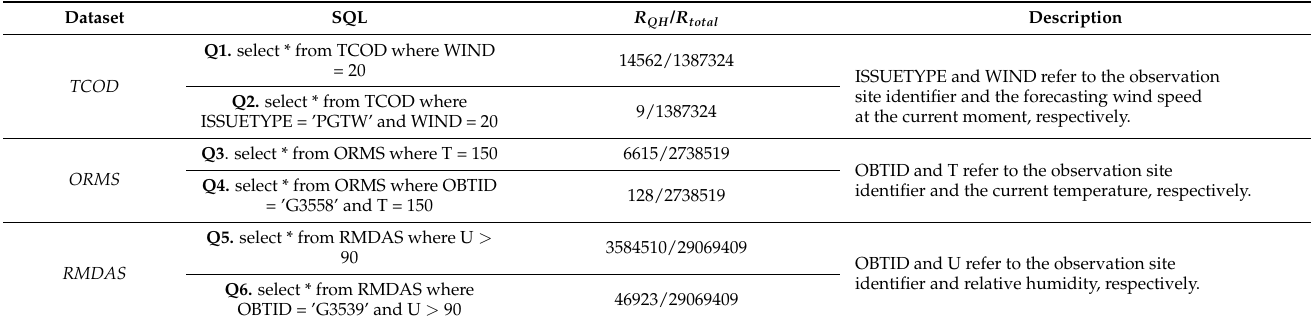
Table 5. Description of query